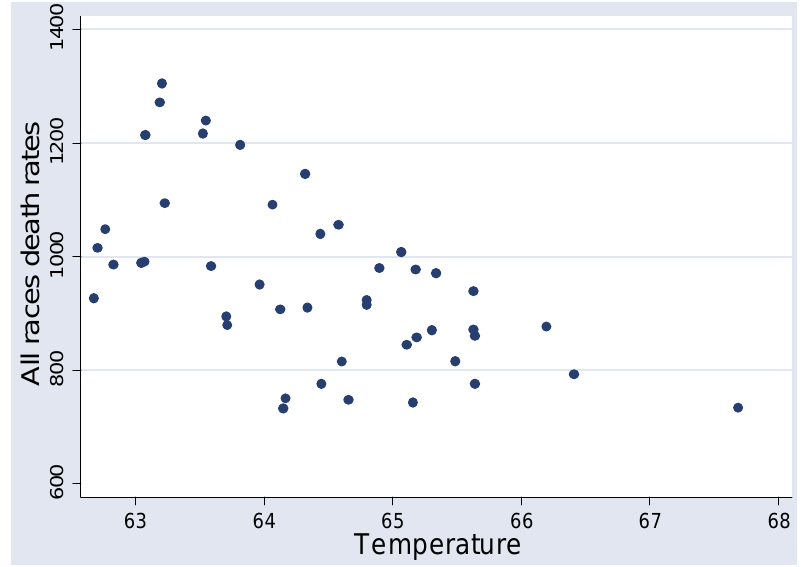
Figure 4. Yearly temperature vs. yearly all races age-adjusted death rates in the continental U.S.,